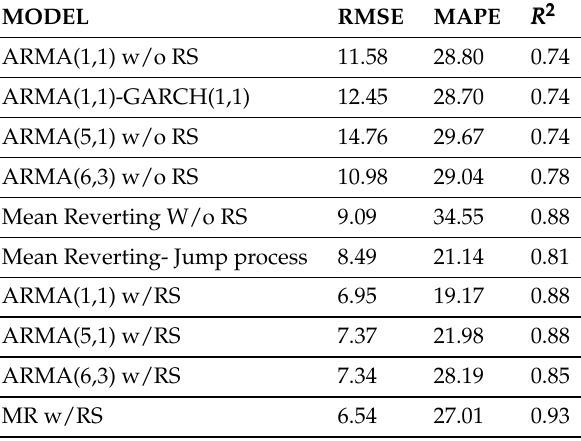
Table 5. Error measures of different models between 2012 and